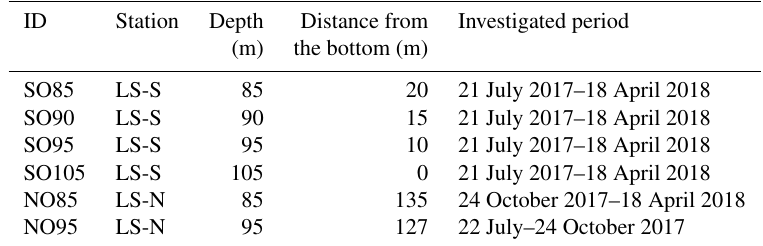
NO85 135 NO95 LS-N